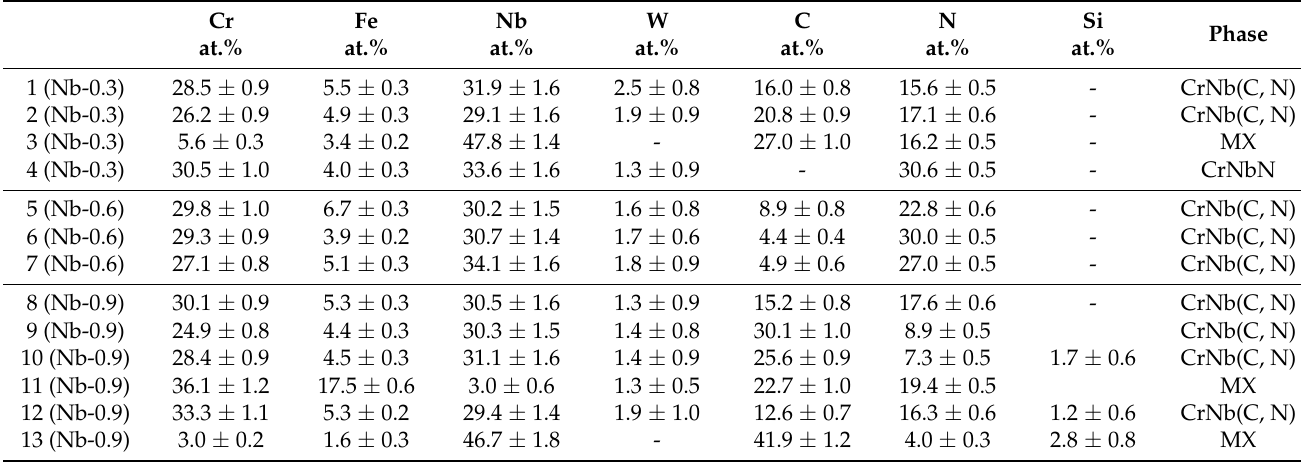
Figure 2. TEM–high-angle annular dark-field observation and analysis of 22Cr25NiWCuCo(Nb) steel specimens after solution treatment at 1200 ◦ C for 2 h: ( a ) Nb-0.3, ( b ) Nb-0.6, and ( c ) Nb-0.9 steel specimens. Table 2. High-resolution TEM (HRTEM)/EDX analysis of different phases in 22Cr25NiWCuCo(Nb) steel specimens after heat treatment at 1200 ◦ C for 2 h (for the marked points in Figure